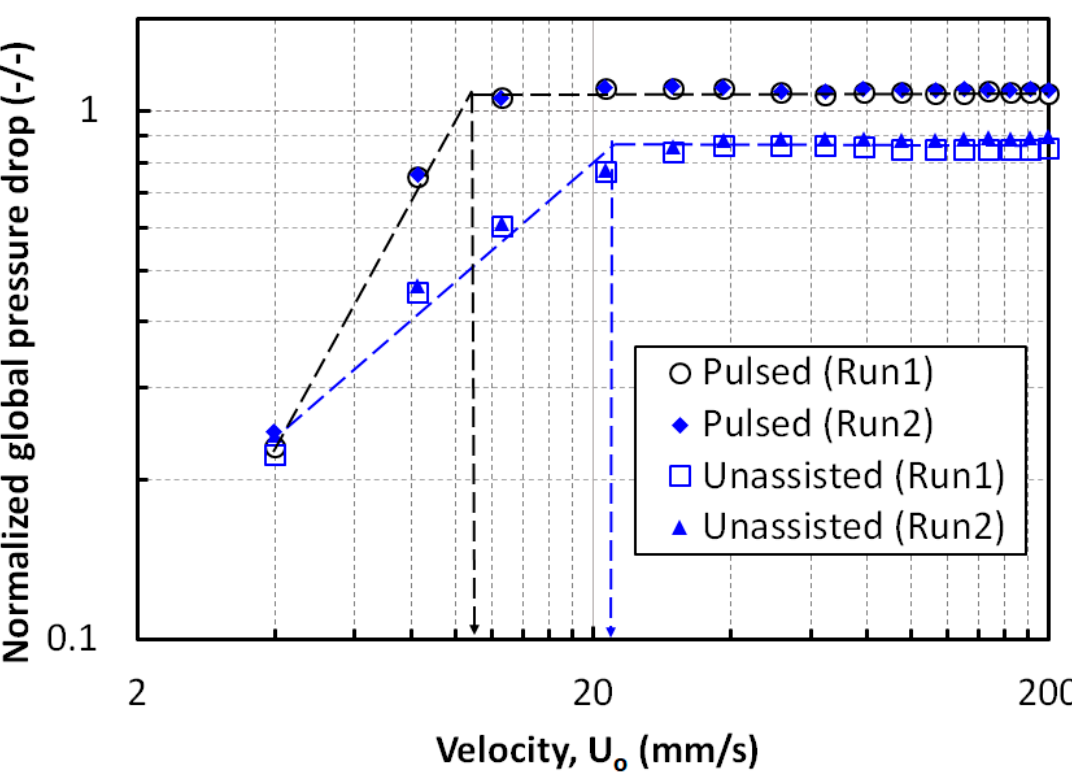
Figure 13. Effect of the velocity on the normalized global pressure drop for the defluidization cycles of unassisted and pulsed fluidizations.